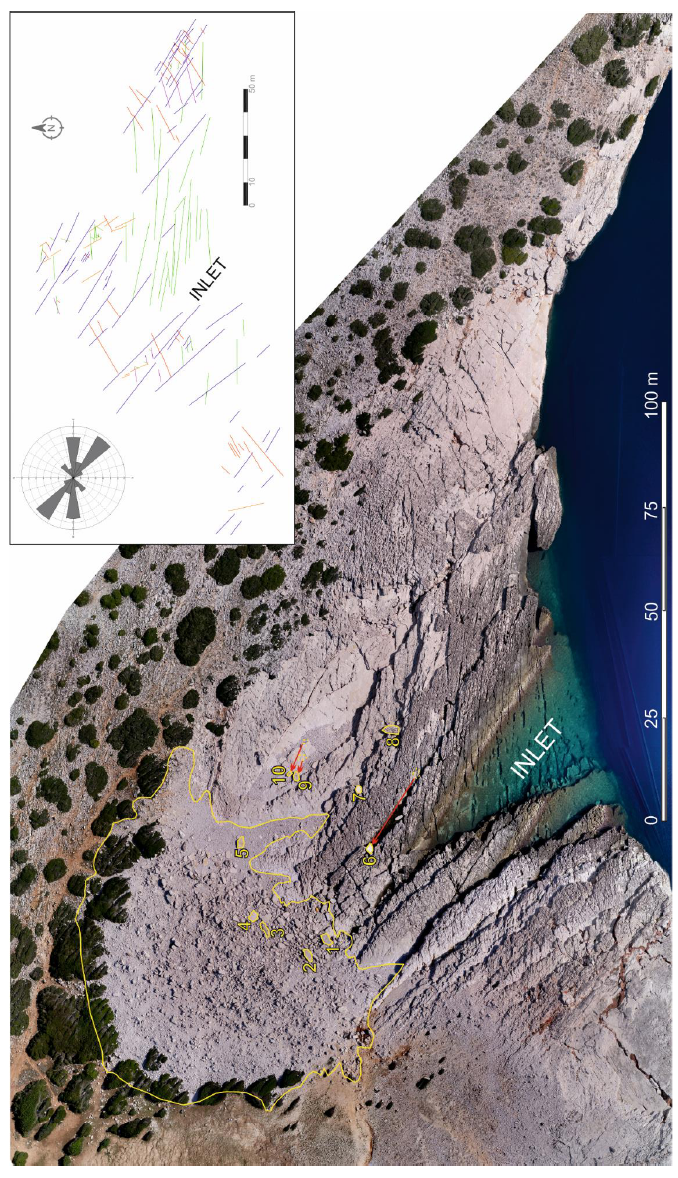
Figure 3. High-resolution UAS orthophoto image (20 October 2020, see Supplement S1) of the investigated area on the island of Mana showing a shallow triangular inlet, highly eroded limestone bedrock in the surroundings, and the coarse-clast deposit on the NW margin (bordered by a long yellow line). The selected boulders are highlight by short yellow lines and marked by numbers (1–10). Observed displacement of the three boulders (6, 9, 10) between June 2018 and October 2020 are marked by red arrows (see also Figures 5F and 6). Inset: Schematic drawing of the fracture system (each set is marked by another color) of the strongly eroded bedrock limestone in front of Mana coarse-clast deposit. The cumulative rose diagram shows all the fracture orientations weighted according to the observed total lengths (circular statistic of the delineated fracture sets according to Oriana software, Kovach Computing